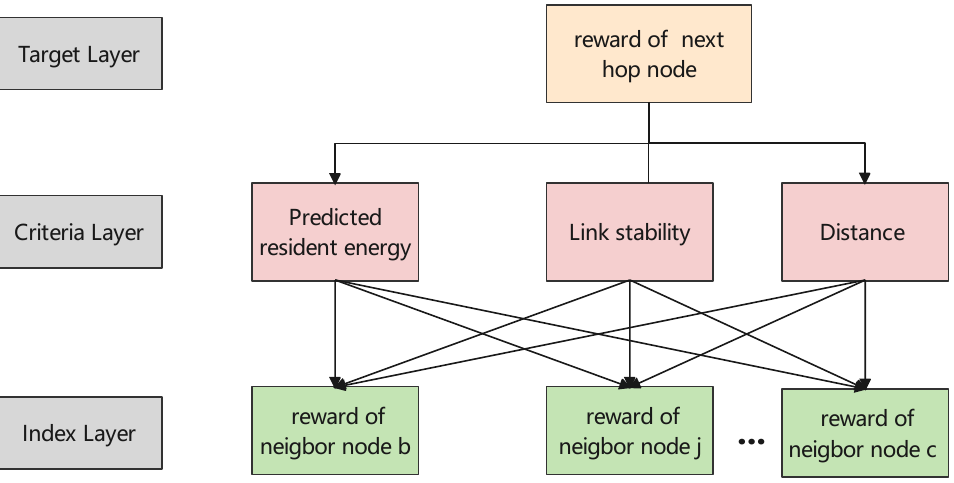
Figure 3. AHP for reward function weight